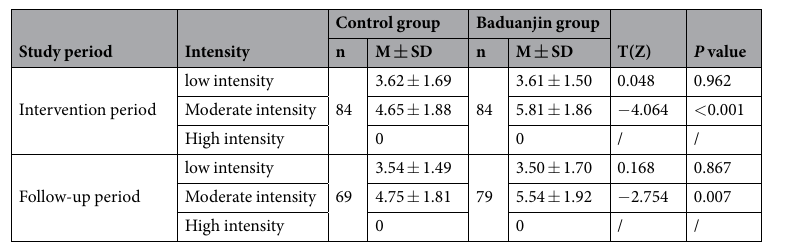
Table 2. Comparison of the daily physical activities between groups during study period (hour, mean ± standard deviation). M: mean; SD: standard